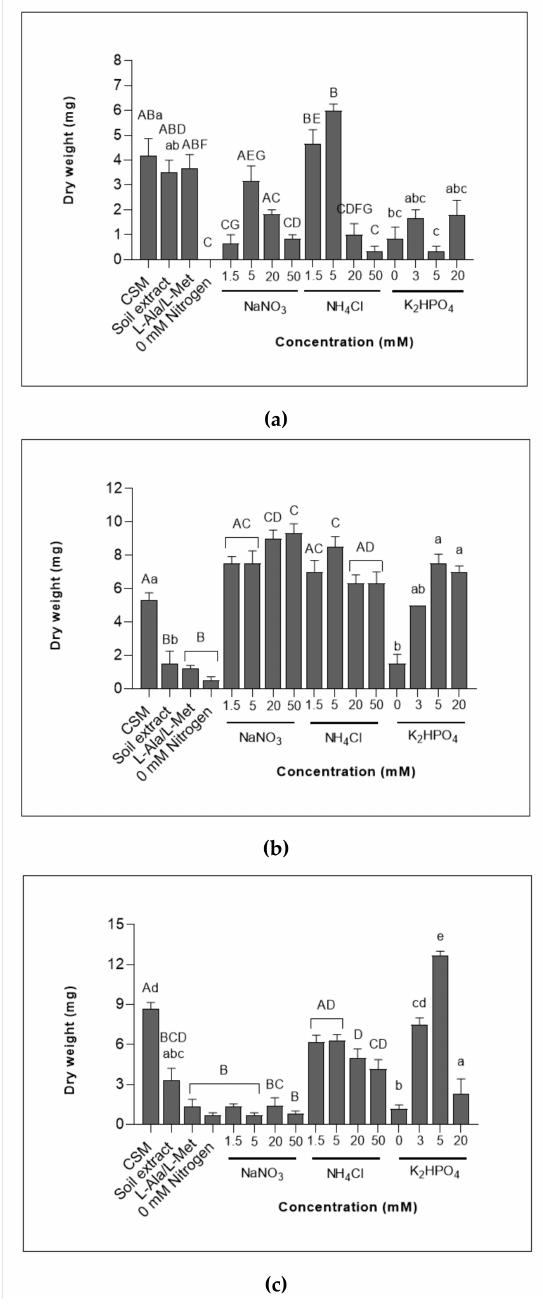
Figure 1. Biomass measured as dry weight (mg) at 4 weeks of growth. ( a ) G. semiglobifer ( b ) Spizel- lomyces sp. ( c ) R. rosea . Error bars are Standard Error of the Mean (SEM). Significant differences in the nitrogen series are denoted by capital-letters (A–G) (F 11, 175 = 39.75, p < 0.05) and lower-case letters (a–e) are used for findings in the phosphorus series (F 5, 75 = 41.97, p <